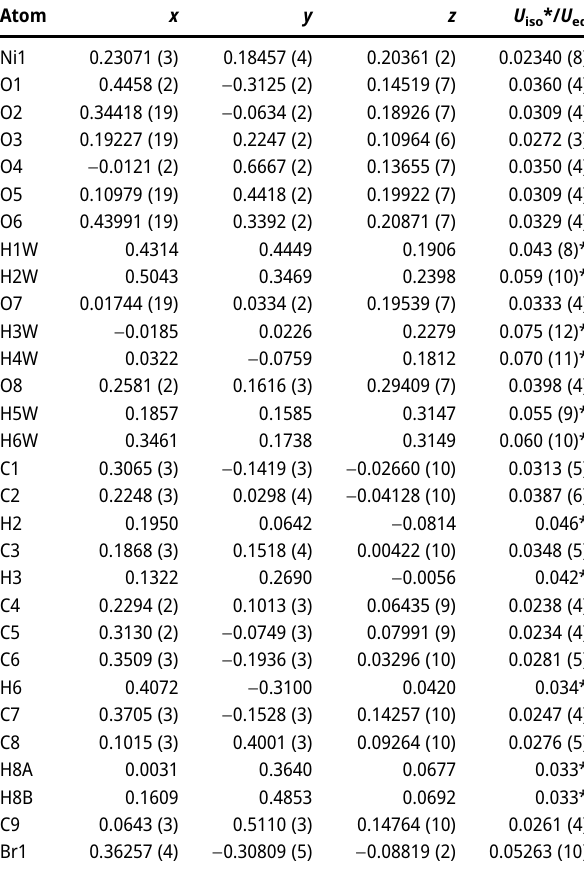
Table  : Fractional atomic coordinates and isotropic or equivalent isotropic displacement parameters (Å 